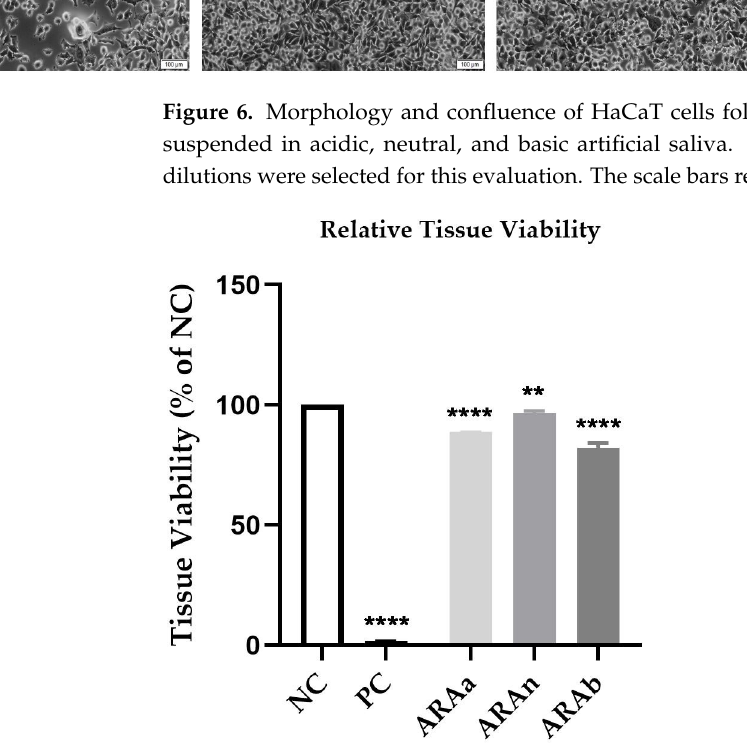
Figure 7. Viability percentage of EpiDerm skin model inserts (EPI-200 SIT) at 18 h post-treatment with the test sample (ARAa, ARAn, and ARAb) at the dilution of 1:1. One-way ANOVA analysis and Dunett’s post-test were performed to determine the statistical differences between sample-treated inserts and negative control-treated inserts (** p < 0.01; **** p < 0.0001). Positive control (PC) is 1% SDS, while the negative control (NC) is DPBS.